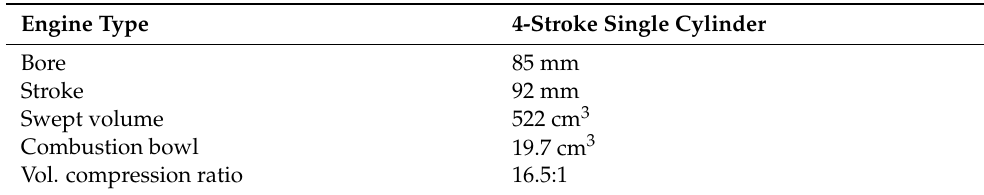
Table 1. Engine specifications [17]. Reprinted with permission from ref. [17] Copyright 2019 SAE International.